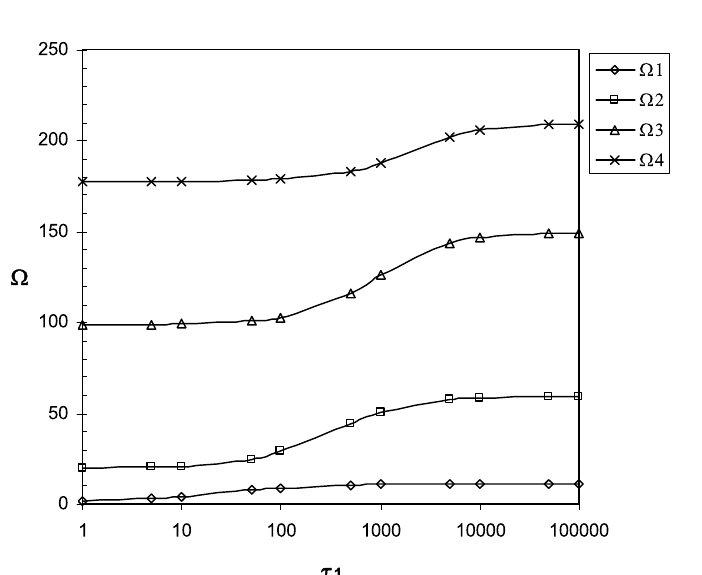
Fig. 2. The fi rst four coupled eigenfrequencies of a SSSS square plate with one sprung mass at its centre ( ξ 1 = η 1 = 0 . 5 ), with respect to the stiffness ratio τ 1 when the mass ratio γ 1 is equal to 0.5. edges. In the present investigation, two cases are considered: the plate with one sprung mass and the plate attached with two sprung masses. It can be seen from Table 5 that increasing the stiffness of the rotational springs does not always lead to increases of the coupled